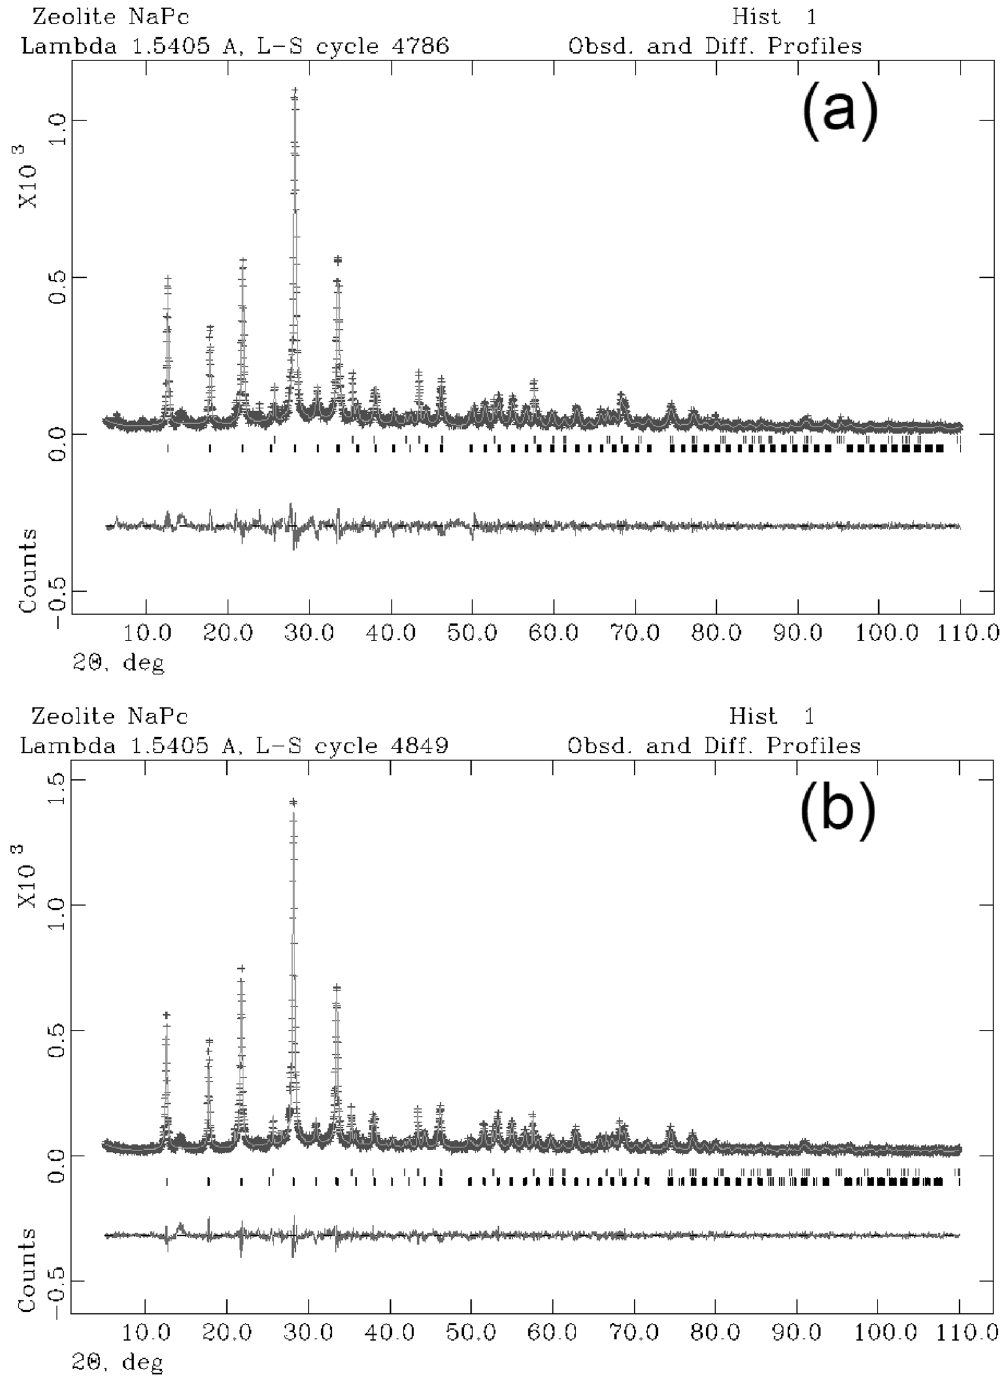
Figure 3. Rietveld refinement plot: observed (+) and calculated profiles and difference plot for Na-P 1 zeolite and corundum NIST 676a with tick marks at the position of the Bragg peaks. From the bottom: Na-P 1 zeolite, curundum NIST 676a. ( a ) Sample at 65 °C; ( b ) Sample at 100